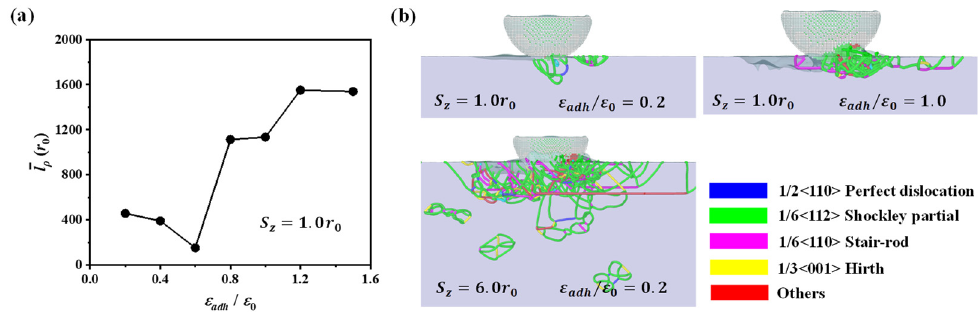
Figure 4. ( a ) Averaged dislocation length as the adhesion increases at the scratch depth of 1.0 r 0 . ( b ) Dislocation structures at the scratch distance of 30 r 0 for two adhesion ratios; only a part of the substrate is shown.